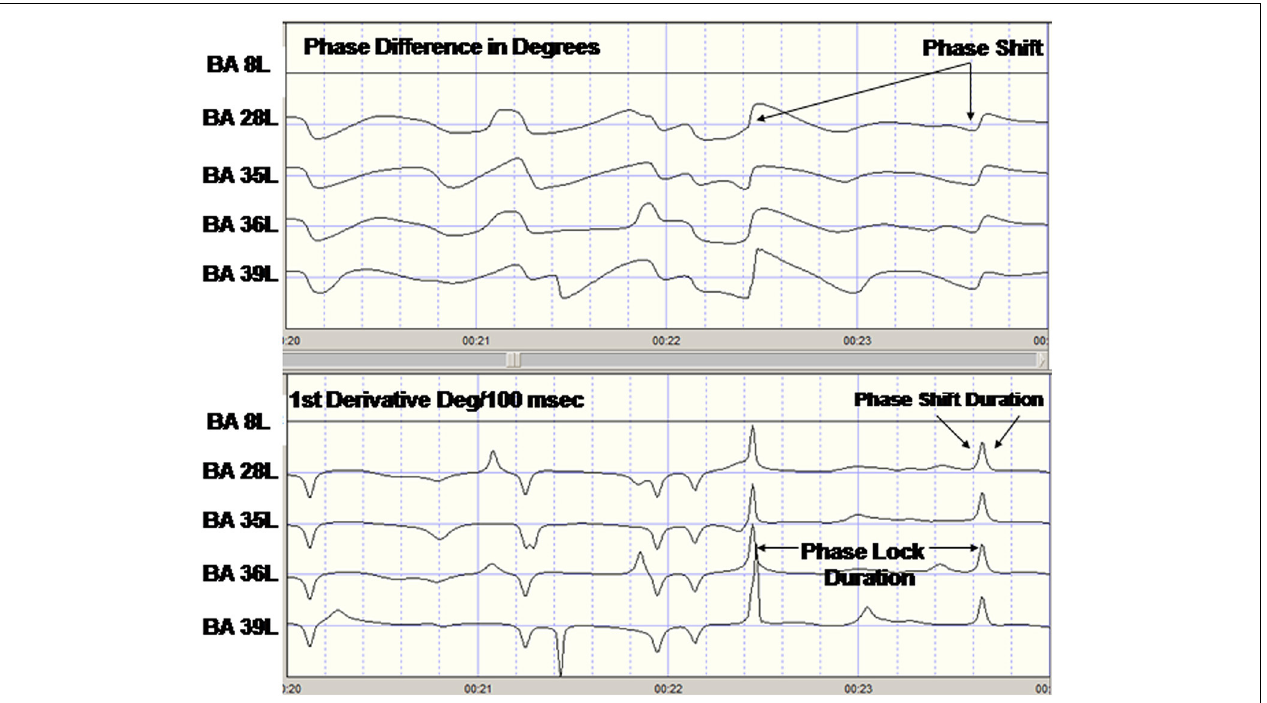
FIGURE 1 | Example of phase reset of LORETA current density time series from one subject. Top are the LORETA EEG phase differences with respect to the left Hemisphere Brodmann area (BA) 8 time series. The last four traces are the phase difference (degrees) for BA8L–BA28L, BA8–BA35L,